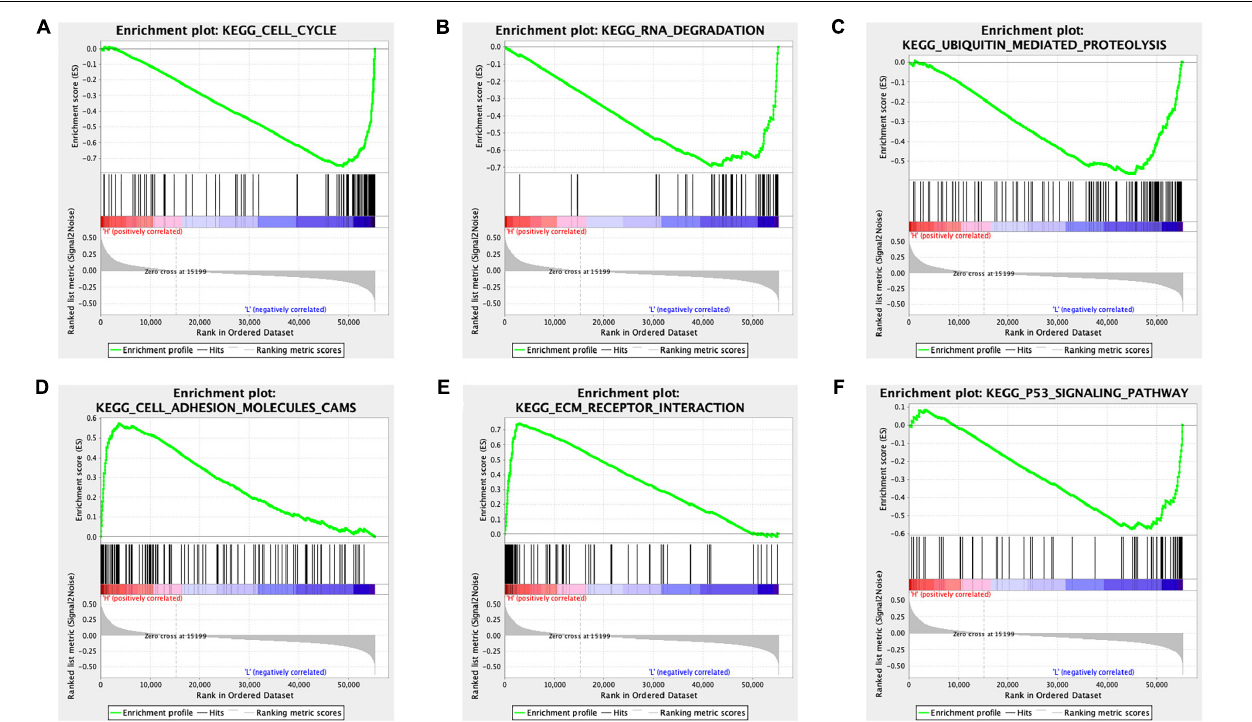
FIGURE 7 | GSEA identified different gene sets between the high and low-risk score groups in STAD. (A) The cell cycle pathway was significantly different between the high- and low-risk score groups. (B) The RNA degradation pathway was significantly different between the high- and low-risk score groups . (C) The ubiquitin-mediated proteolysis pathway was significantly different between the high- and low-risk score groups. (D) The cell adhesion molecules pathway was significantly different between the high- and low-risk score groups. (E) The EMC receptor interaction pathway was significantly different between the high- and low-risk score groups. (F) The p53 signaling pathway was significantly different between the high- and low-risk score